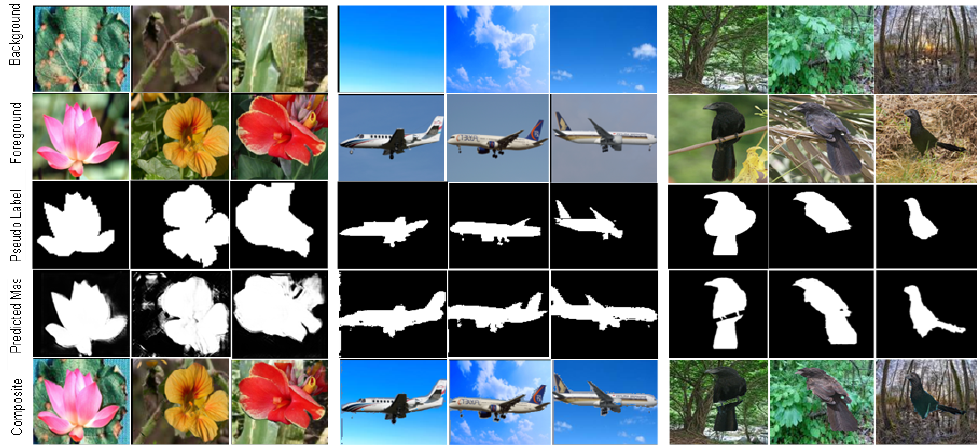
Figure 4. Visualization results with the proposed SS-CPGAN on the datasets: Oxford 102 Flowers ( left ), FGVC Aircraft ( center ), and Caltech-UCSD Birds (CUB) 200-2011 ( right ).